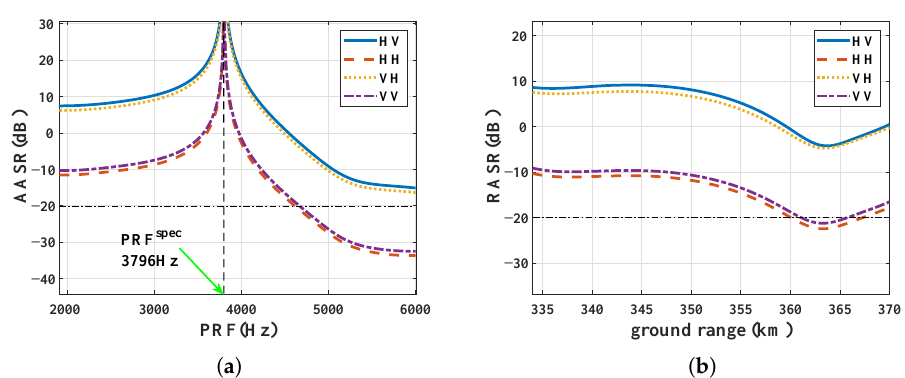
Figure 7. AASR and RASR performance of system #2 by MI method. ( a ) the AASR versus PRF; ( b ) the RASR (PRF = 3756 Hz) versus the ground range.